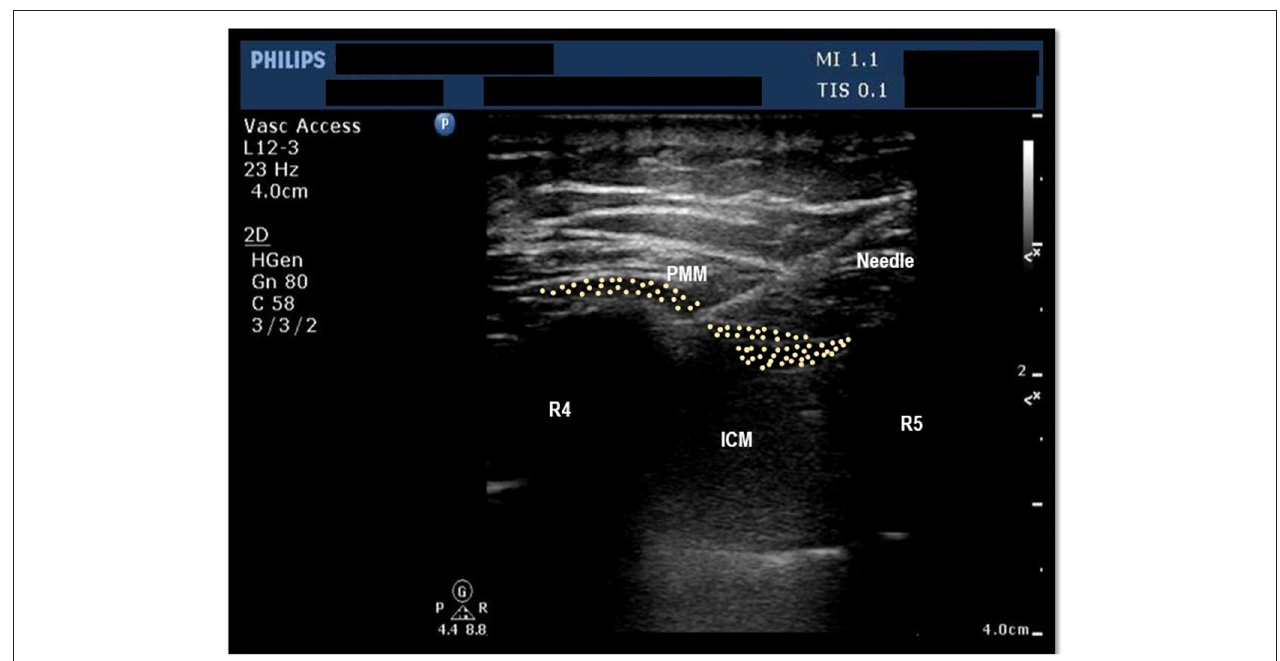
FIGURE 2 | Ultrasound image of the chest wall showing anterior chest wall structures at the level of 4th Intercostal space. PMM, Pectoralis major muscle, ICM, Intercostal Muscles, R4, Fourth rib, R5, Fifth rib, Shows the position of needle, pleura and lung